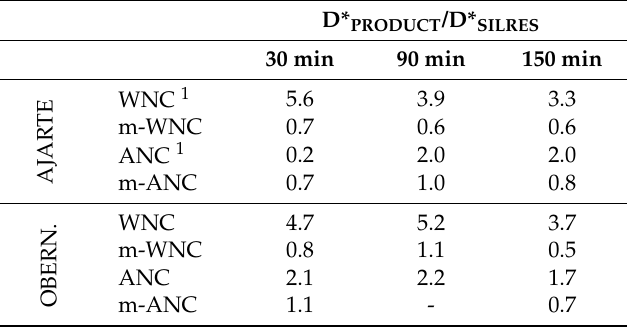
Table 9. Ratio of discolouration values (D*) of Ajarte and Obernkirchen stones treated with WNC/ANC (D* PRODUCT ) and corresponding values for the reference non-photocatalytic product Silres BS 290 (D* SILRES ) after 30, 90 and 150 min irradiation. D* PRODUCT /D*